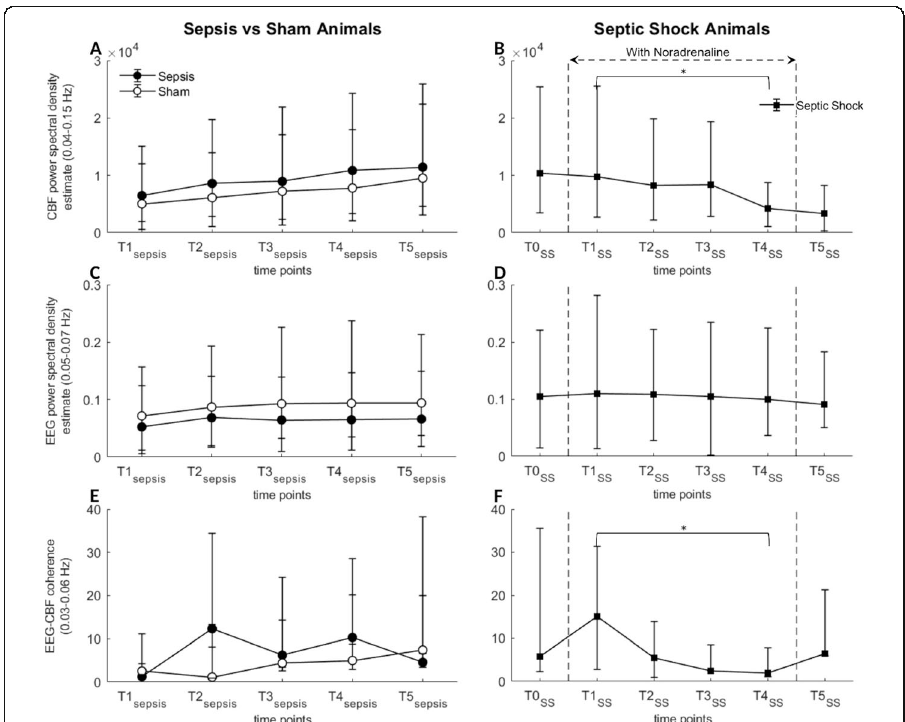
Fig. 3 Temporal evolution of neurovascular coupling measured by coherence between periodic fluctuations of cortical activity and cerebral blood flow. Cerebral blood flow velocity (CBFv) spectral power (0.04 – 0.15Hz frequency band; a , b ), second-level spectral power of gamma activity envelope (E γ ; 0.05 – 0.07Hz frequency band; c , d ), and their magnitude-squared coherence (MSC; 0.03 – 0.06Hz frequency band; e , f ) in sepsis vs. sham groups ( a , c , e ) and in septic shock group ( b , d , f ), expressed as median and inter-quartile range. * p < 0.05 by RMANOVA test analysis. No significant difference, neither in CBFv nor in E γ spectra fluctuations nor in MSC, was observed in sepsis and sham animals in any of the frequency bands considered. In the septic shock group, there was a significant decrease between T1 SS and T4 SS in the spectrum of CBFv fluctuations between 0.04 and 0.15Hz and a significant decrease in MSC for frequencies between 0.03 and 0.06Hz. Comparative analysis for other frequencies of CBFv and E γ spectral power and MSC are presented in Supplemental Figure S3 (a, b, c). Power spectral density estimation are expressed in √ dB/Hz